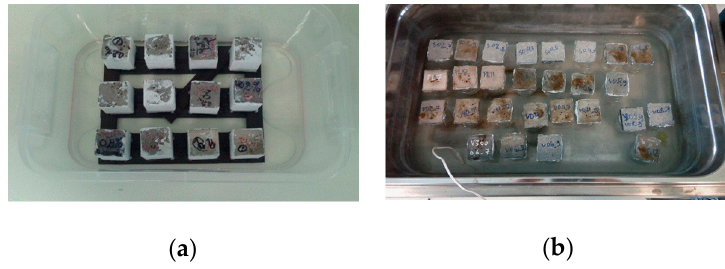
Figure 2. Pictures of the ( a ) water absorption, and ( b ) gas permeability test set-ups.